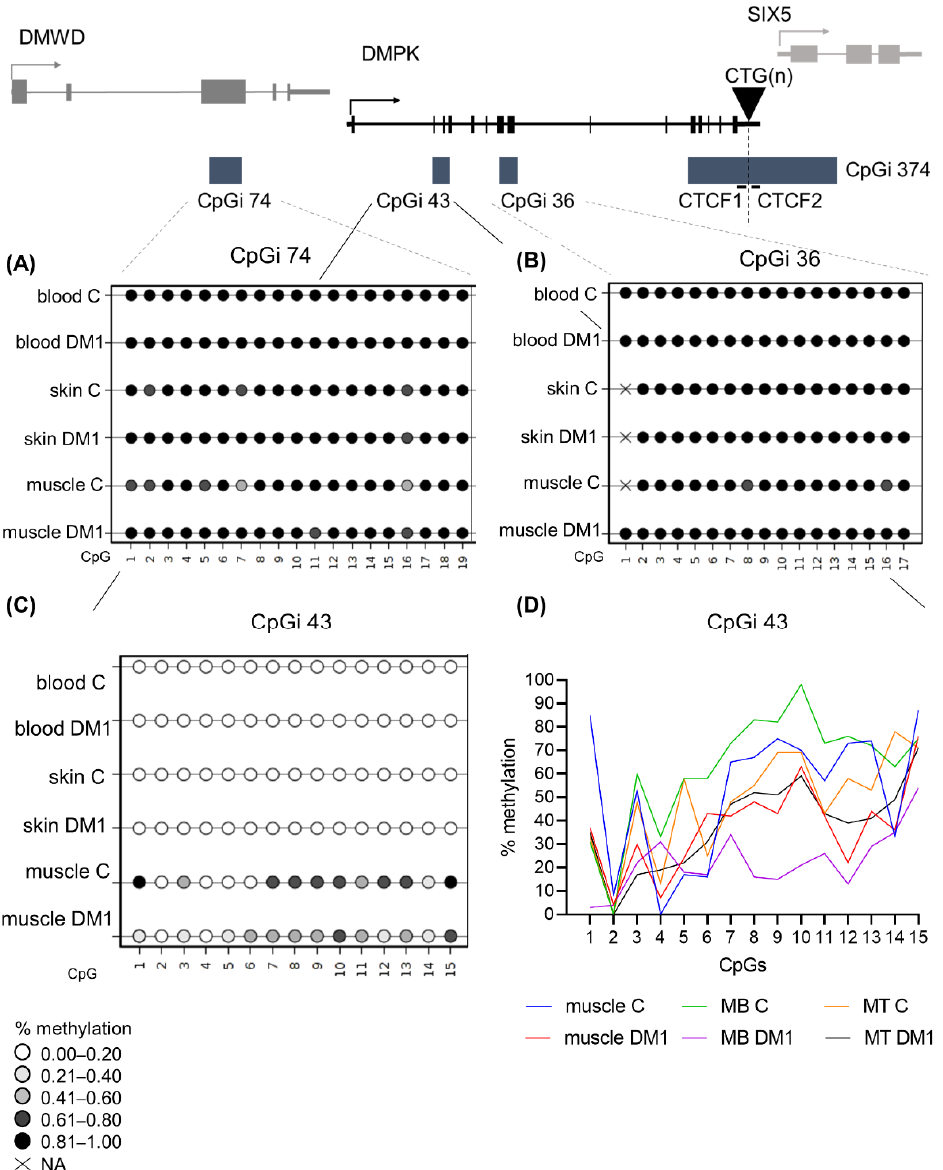
Figure 4. DNA methylation profile at CpGi 43 showed specific hypomethylation in DM1 muscle tissue and muscle-derived cells. ( A – C ) Averages of DNA methylation profiles across the three studied tissues, blood, skin and muscle, in patients versus controls for CpGi 74 ( A ), for CpGi 36 ( B ) and CpGi 43 ( C ). Included patients are from the juvenile, adult and late onset clinical category ( n = 5 for blood, n = 3 for skin, n = 7 for muscle and n = 4 for controls). Each circle represents a CpG dinucleotide. The colour gradient represents the level of methylation indicated in the legend assessed by sodium bisulphite sequencing. ( D ) Representation of the DNA methylation profiles of muscle and muscle-derived cells (myoblasts and myotubes) in CpGi 43 assessed by bisulphite sequencing.